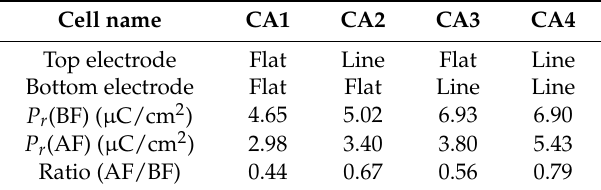
Table 1. Pr before (BF) and after (AF) fatigue test with different electrode